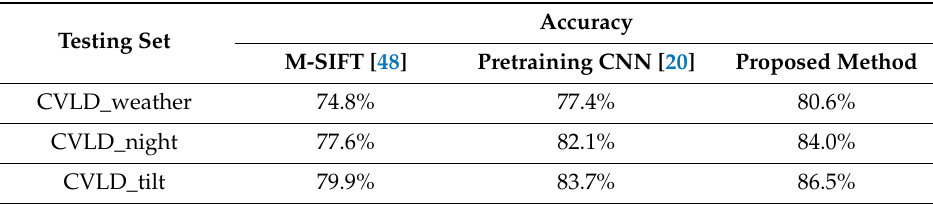
Table 8. Accuracy comparison on complex